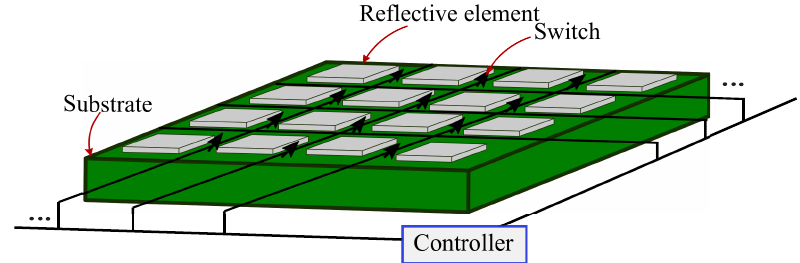
Figure 1. Meta-surface with composed by an array of passive reflective elements.